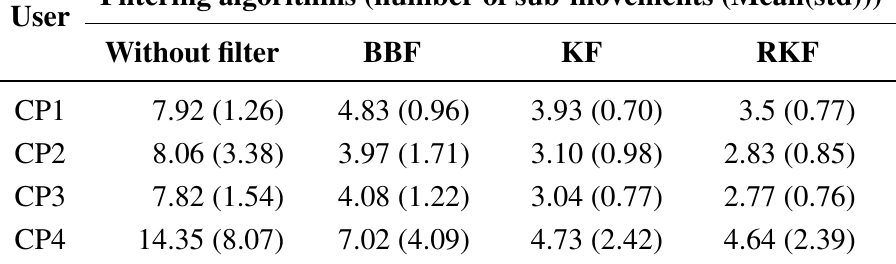
Table 5. Mean number of sub-movements per filtering algorithm (std).